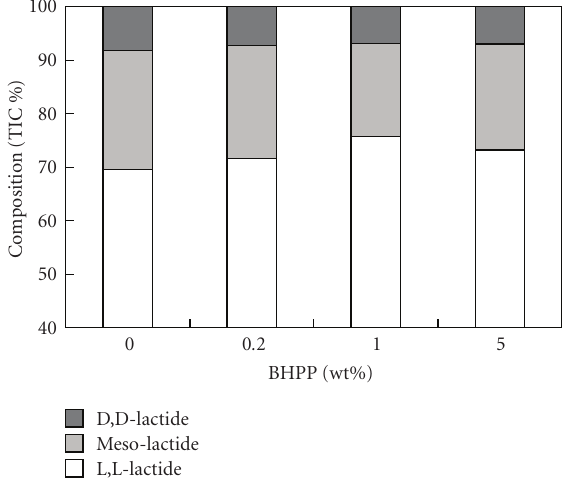
Figure 11: Composition ratios of pyrolyzates evaporated from PLLA/BHPP during heating at 300 ◦ C for 30